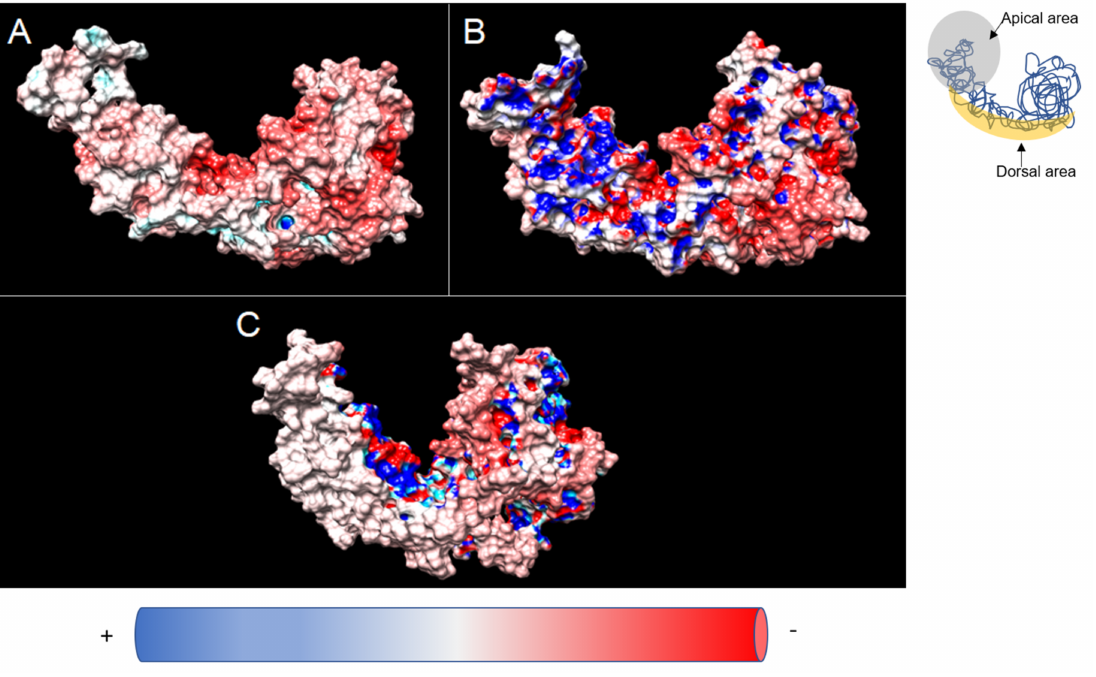
Figure 3. Electrostatic potential of ATP-bound CCT5 subunits. ( A , B , C ): wild-type, and mutants Leu224Val and His147Arg, respectively. The scale applied ranges from − 10 kT/e to +10 kT/e, where k is the Boltzmann constant, T the temperature in K, and “e” the charge. Neutrally charged areas are white, negatively charged areas are red, and positively charged areas are blue. See Supplementary Materials, Video